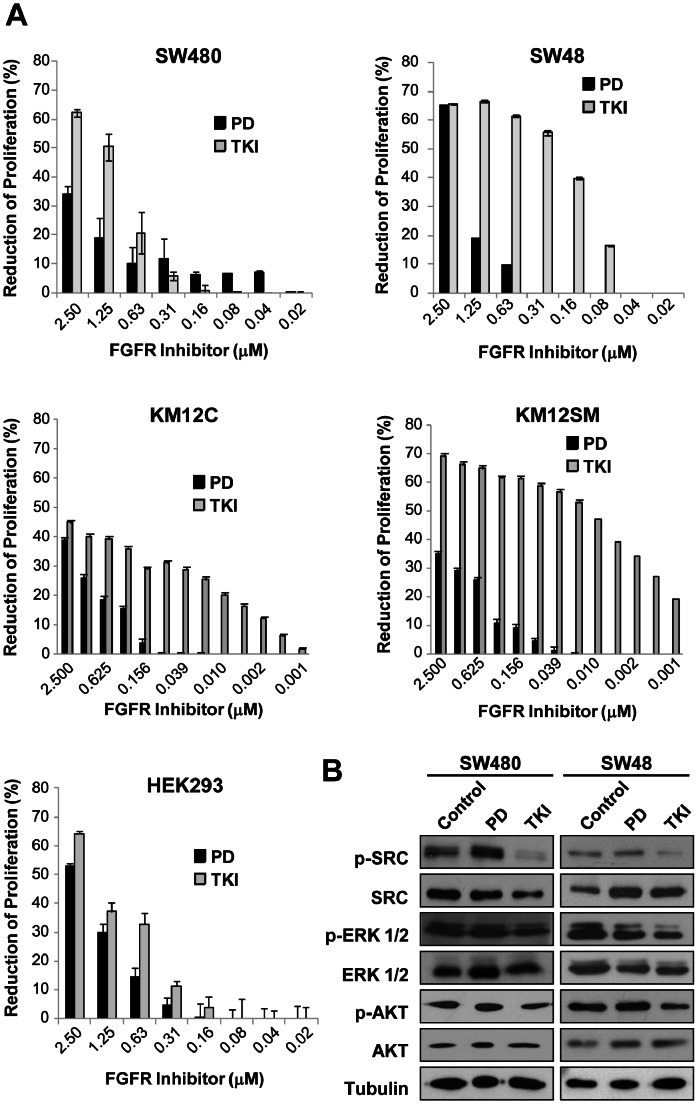
Impact of FGFR4 targeting using kinase inhibitors on colorectal cancer growth.
A.
In vitro cell proliferation inhibition assays were carried out using tyrosine kinase specific inhibitors. Experiments were performed in DMEM supplemented with 10% FBS and antibiotics. After 72 h of incubation with indicated concentrations, cell viability was determined by a MTT assay at 570 nm and represented as reduction of proliferation (%). Absorbance of the untreated control cells was taken as 100% of cellular growth and the reduction of the cellular growth calculated according to the following formula: (relative growth of untreated cells - relative growth of treated cells)/relative growth of untreated cells)×100. Each column is the average of three independent experiments (each concentration tested in triplicate). Error bars indicate the standard deviation of the assay. B. Targeting of FGFR4 using kinase inhibitors impairs downstream signaling pathways. Parental SW480 and SW48 cells were incubated with indicated inhibitors at a concentration of 1.25 µM for 5 h, lysed with 0.5% SDS and subjected to western blot analysis using specific antibodies against phosphorylated and total AKT, ERK1/2 and SRC. Tubulin was used as loading control.